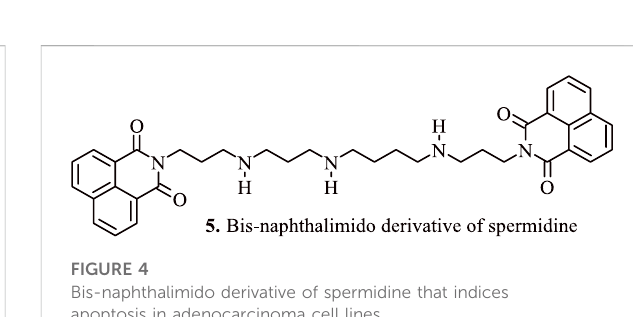
FIGURE 4 Bis-naphthalimido derivative of spermidine that indices apoptosis in adenocarcinoma cell